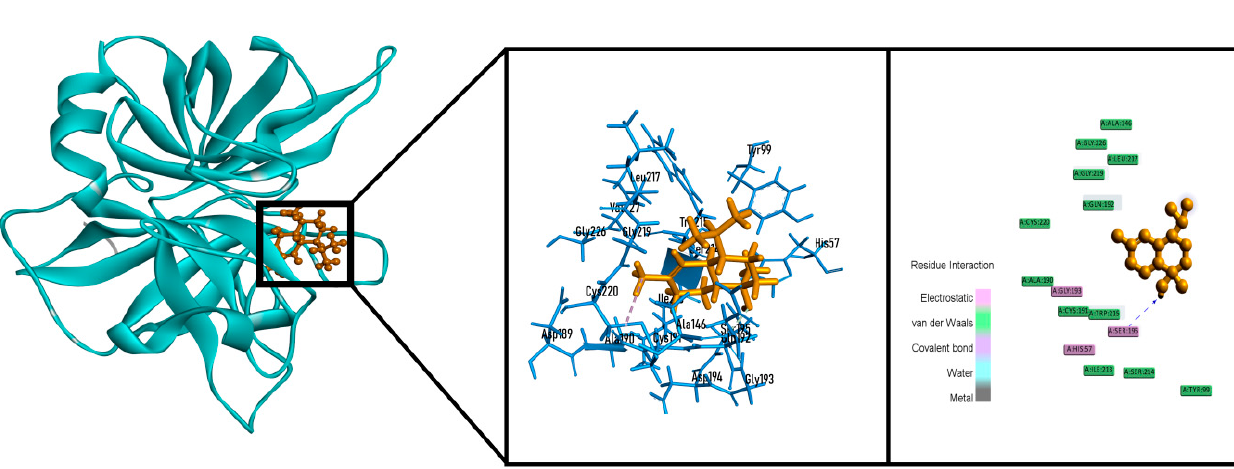
Figure 7. Best docked poses and 2D interactions of T-cadinol tissue plasminogen activator receptor (PDB: 1A5H) for thrombolytic activity. In our anxiolytic docking investigation 1, 2-dimethylbenzene ( − 3.658 kcal/mol), 4- terpineol ( − 5.143 kcal/mol), α -cadinene ( − 3.442 kcal/mol), bullatantriol ( − 4.098 kcal/mol), binding attraction than diazepam ( − 3.140 kcal/mol) against potassium channel receptor (Table 4). Whereas, 4-terpineol showed best score by interacting with one hydrogen bond (leu86) and one hydrophobic bond (ALA54) (Figure